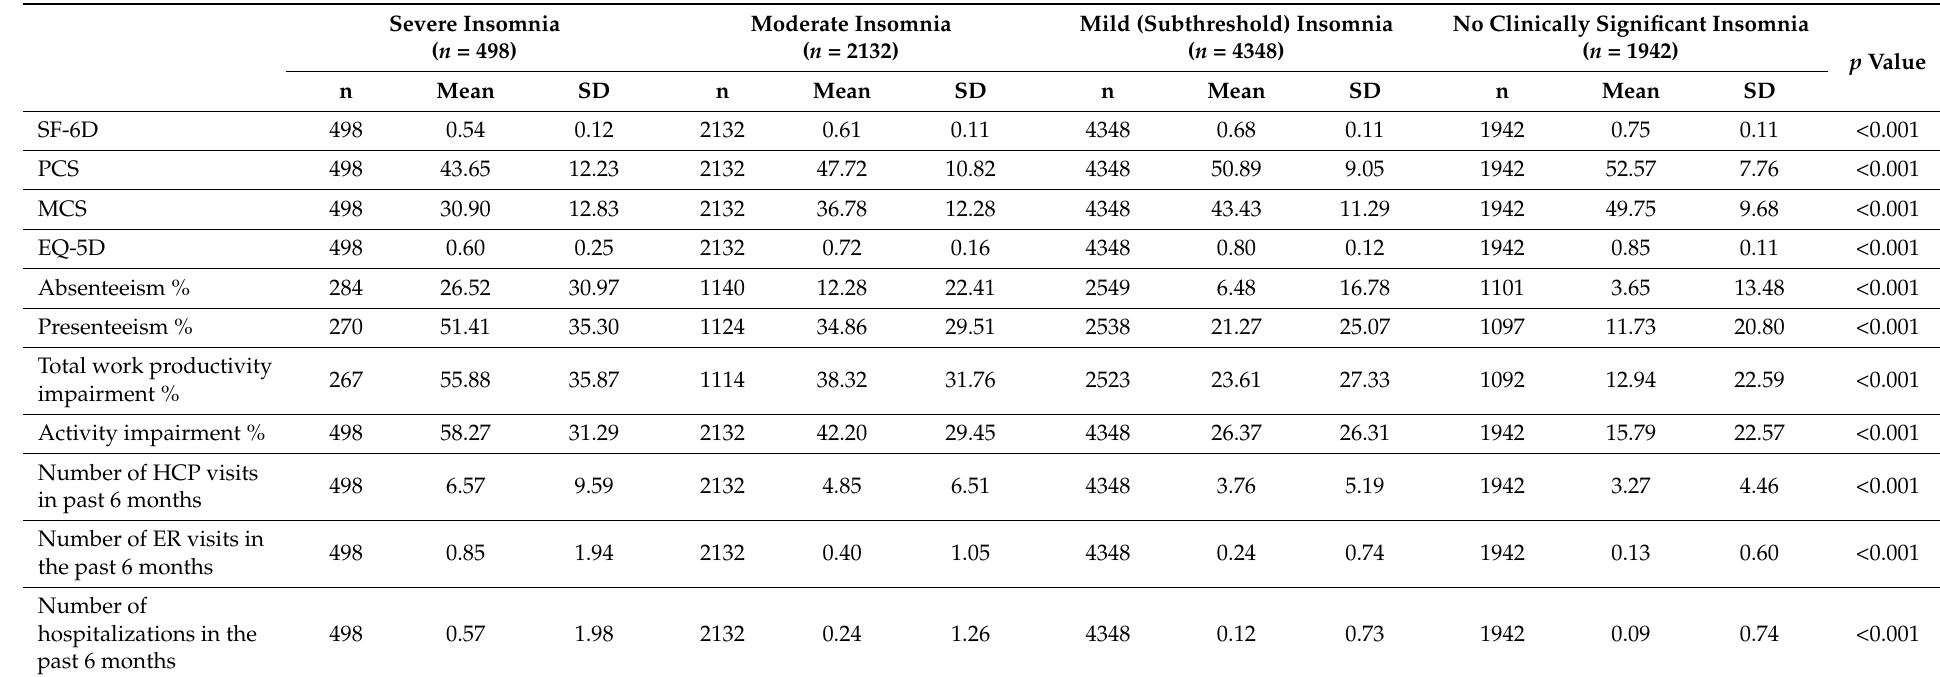
Table 2. Unadjusted outcome differences by ISI severity